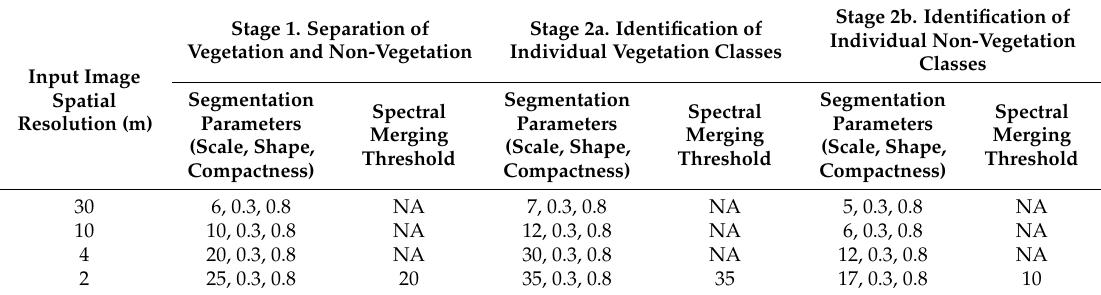
Table 2. Segmentation parameter settings for multi-stage object-based